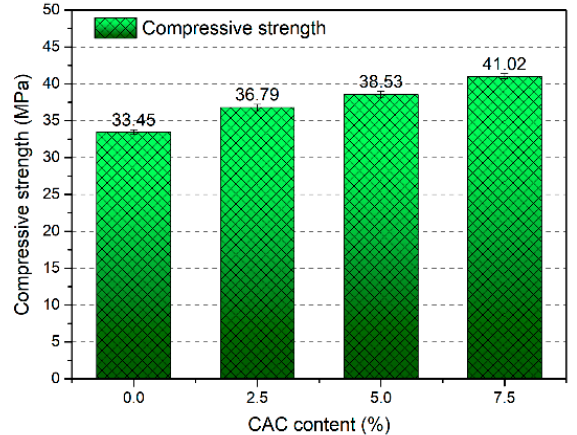
Figure 3. The compressive strength of fly ash geopolymer concrete (FAGC) with different CAC content. Table 3. Results of mechanical properties of FAGC.